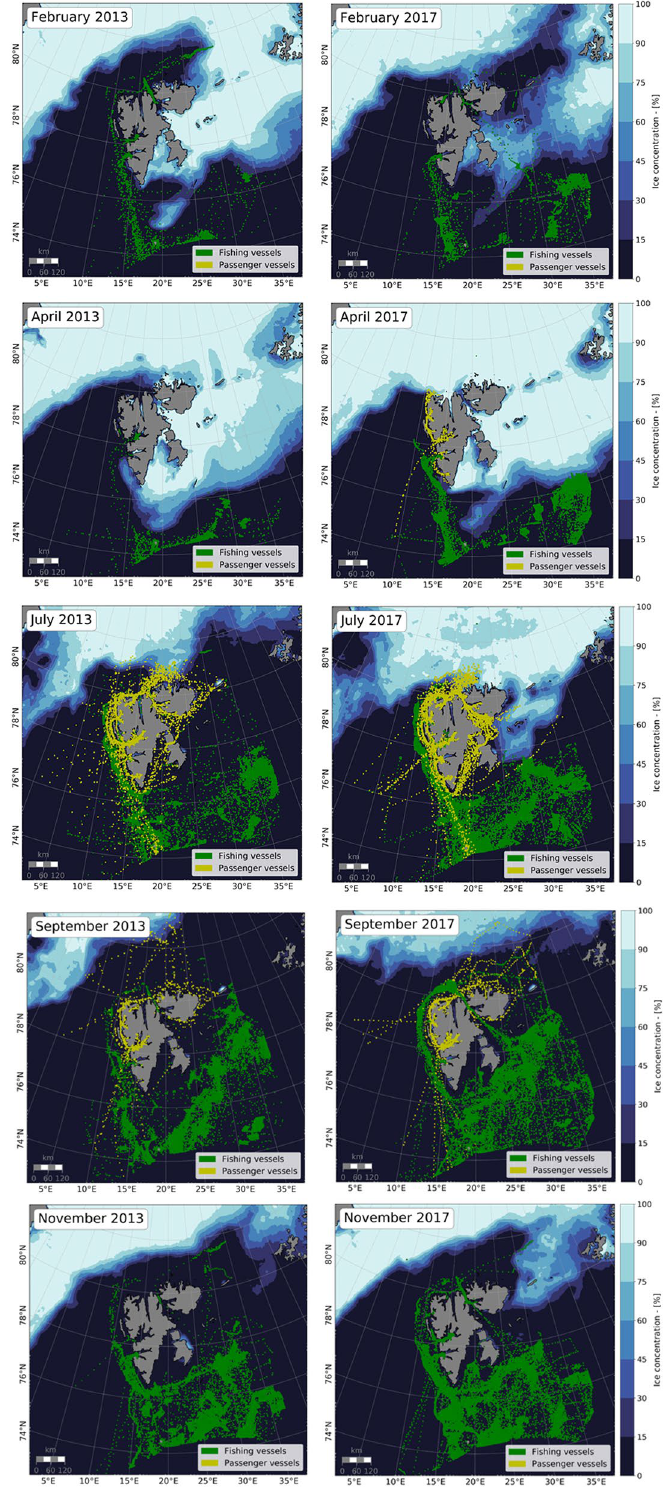
Figure 3. Average sea ice concentration, and fishing (green) and passenger (yellow) vessel positions in February, April, July, September and November of 2013 (left) and 2017(right). Figures generated with python 3.7.x (https ://www.pytho